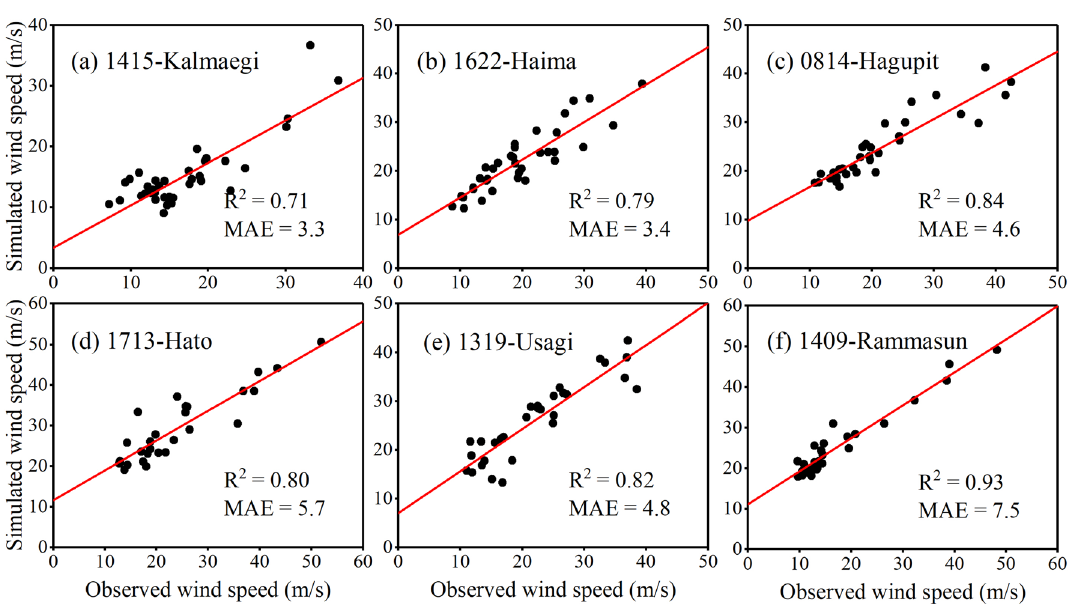
Fig. 2 Comparison of the maximum wind speed (MWS) between ground observations at weather stations and the grid simulations by the Hol- land model of tropical cyclones in Guangdong Province, South China. MAE = mean absolute